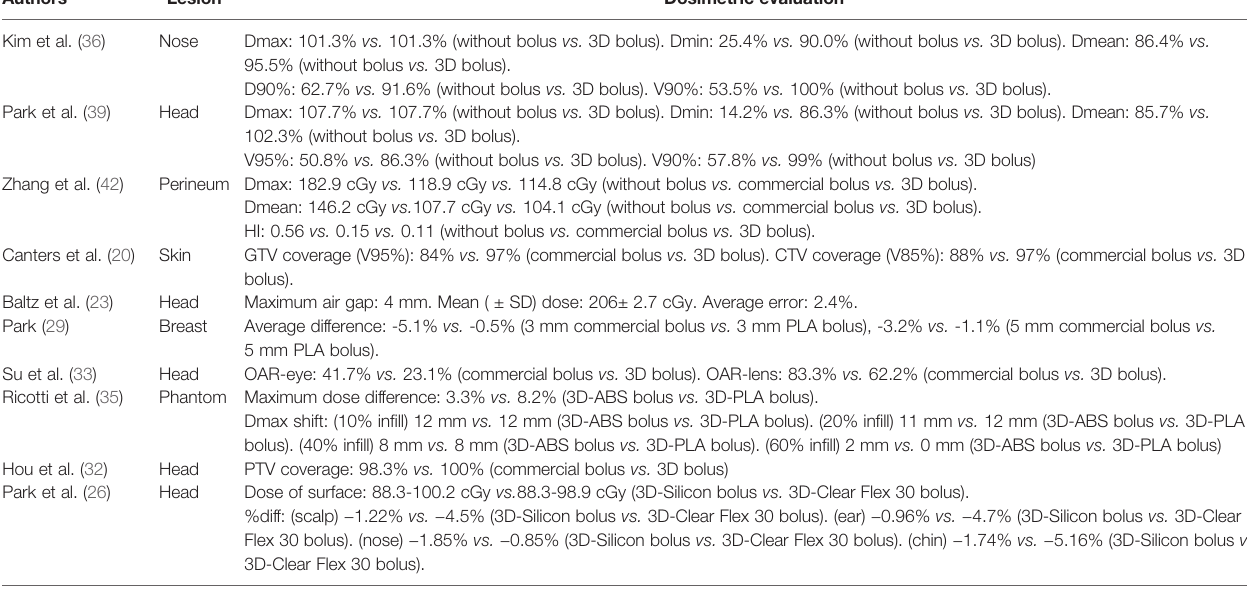
TABLE 2 | Pre-clinical dosimetric evaluation of the 3D-printed bolus. Authors Lesion Dosimetric evaluation Kim et al.